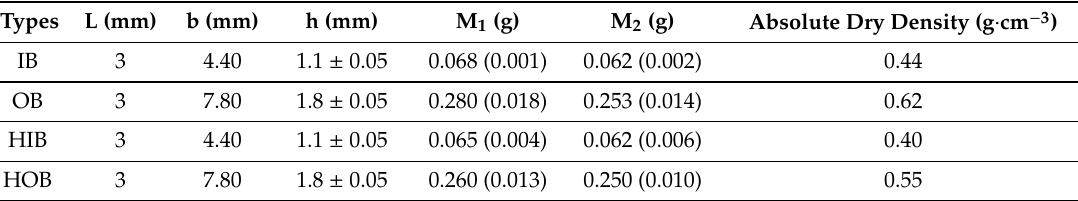
Table 1. Specification of raw materials and the heat-treated